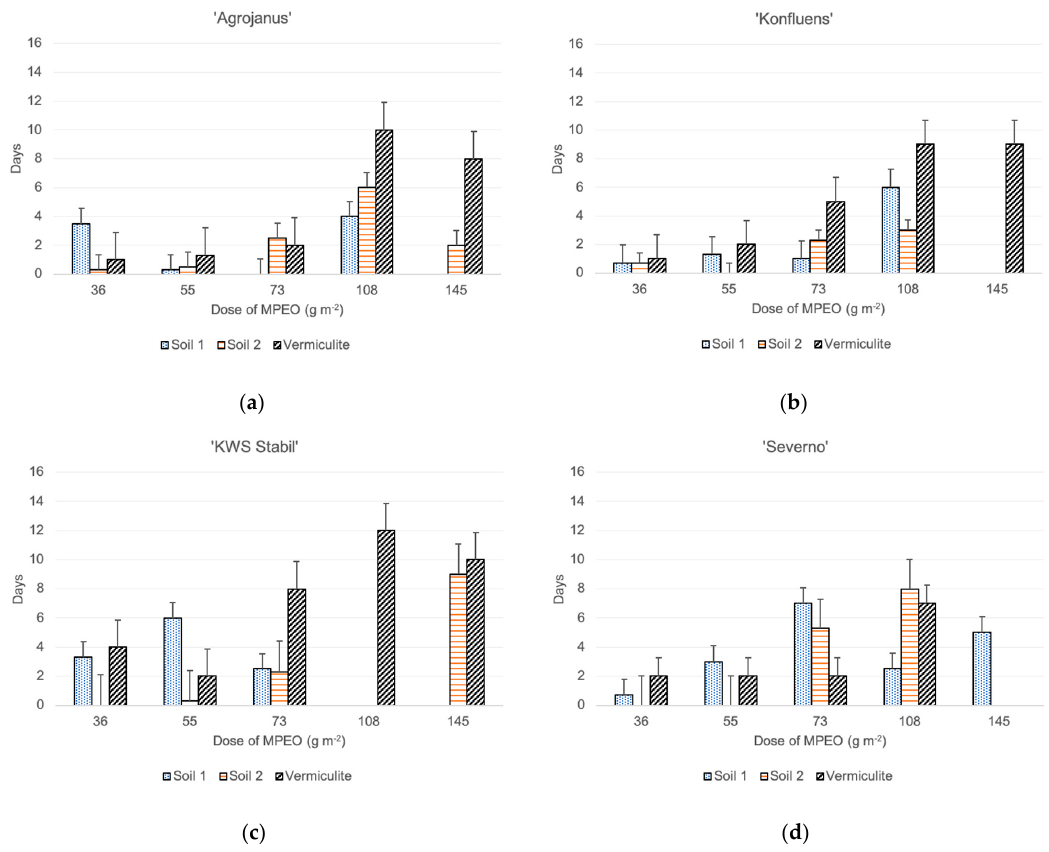
Figure 1. The effect of microencapsulated peppermint oil (MPEO) on delay of maize emergence (in Figure 1. The e ff ect of microencapsulated peppermint oil (MPEO) on delay of maize emergence (in days) depending on the substrate (mean values + standard error); single cross hybrids: ( a ) ‘Agrojanus’ and ( b ) ‘Konfluens,’ and triple cross hybrids: ( c ) ‘KWS Stabil’ and ( d )